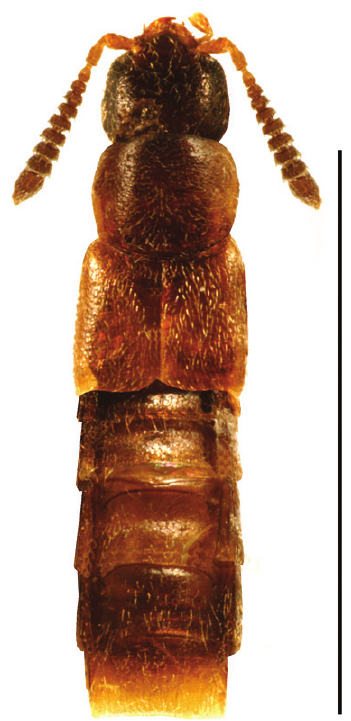
Fig. 3. Dorsal habitus photograph of Meotica exilis. Scale = 1